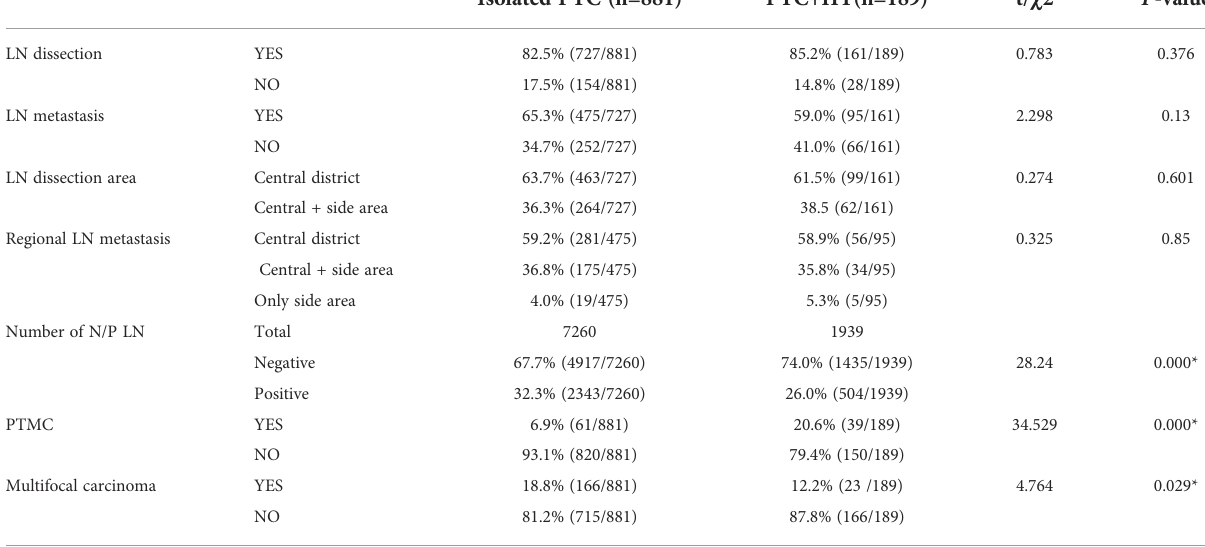
TABLE 4 Patient Characteristics of isolated PTC and PTC with